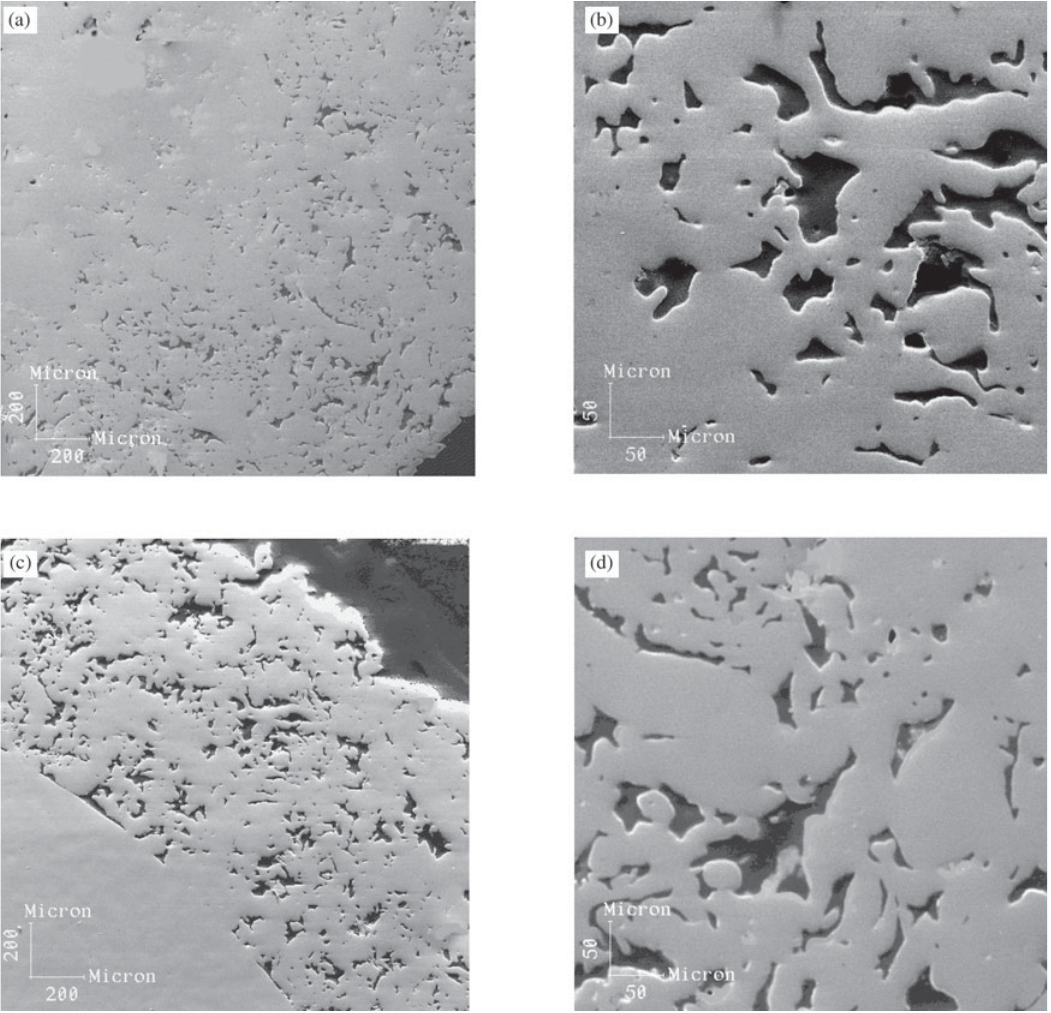
Figure 3. SEM photomicrographs showing the coatings of polished specimens compacted at 200 MPa: type 1 in (a) (b) and type 3 compacted at 200 MPa in (c)